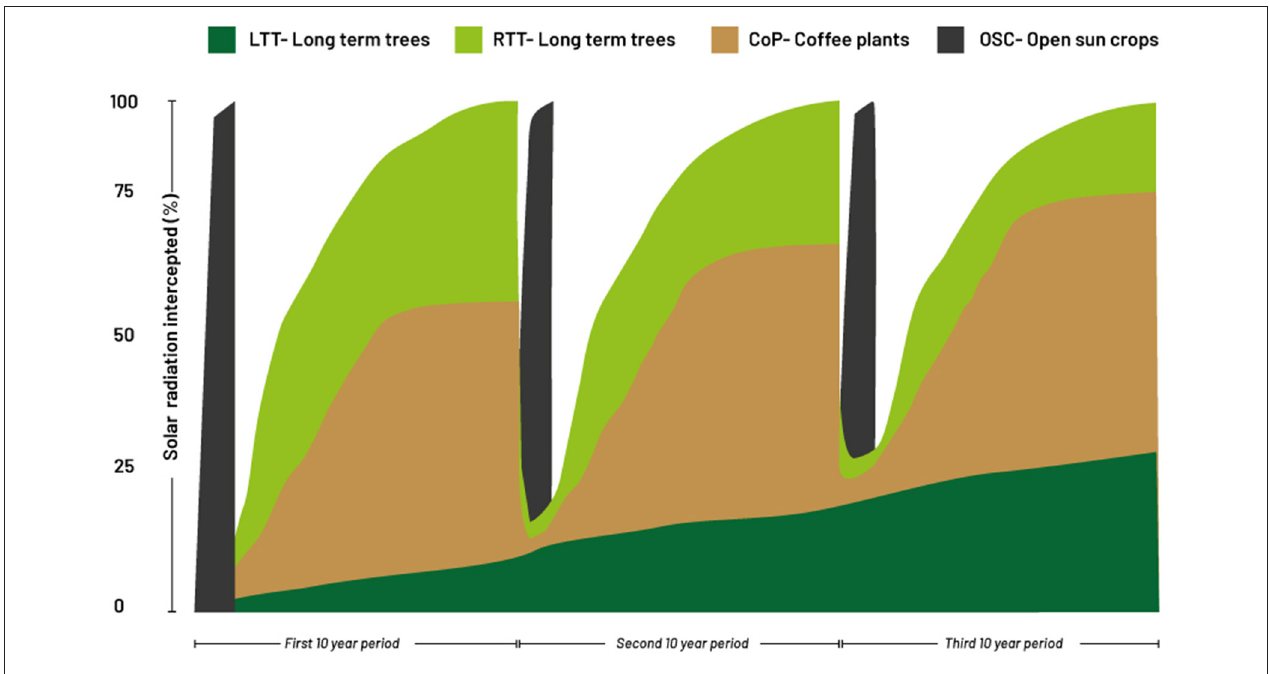
FIGURE 7 | Hypothetical dynamic shifts during three coffee renovation